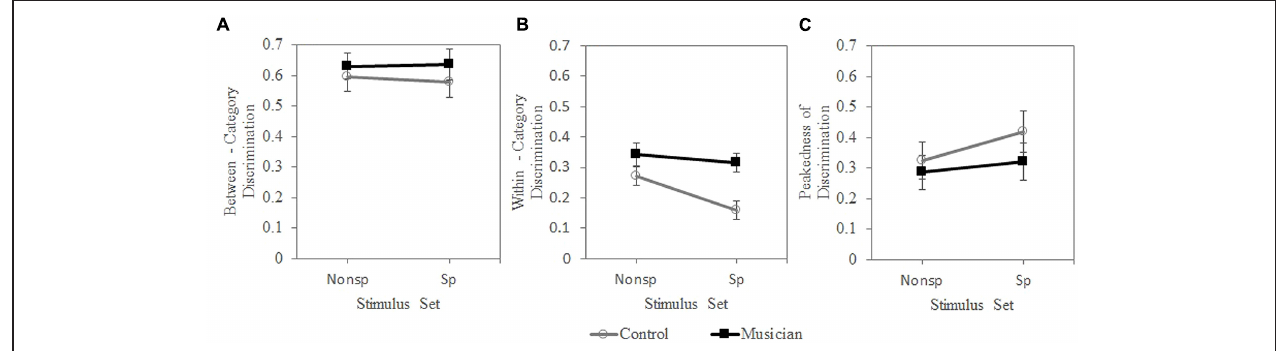
FIGURE 3 | Proportion of “different responses for the discrimination task.” (A) between-category, (B) within-category, (C) peakedness of discrimination. S, speech; NS,